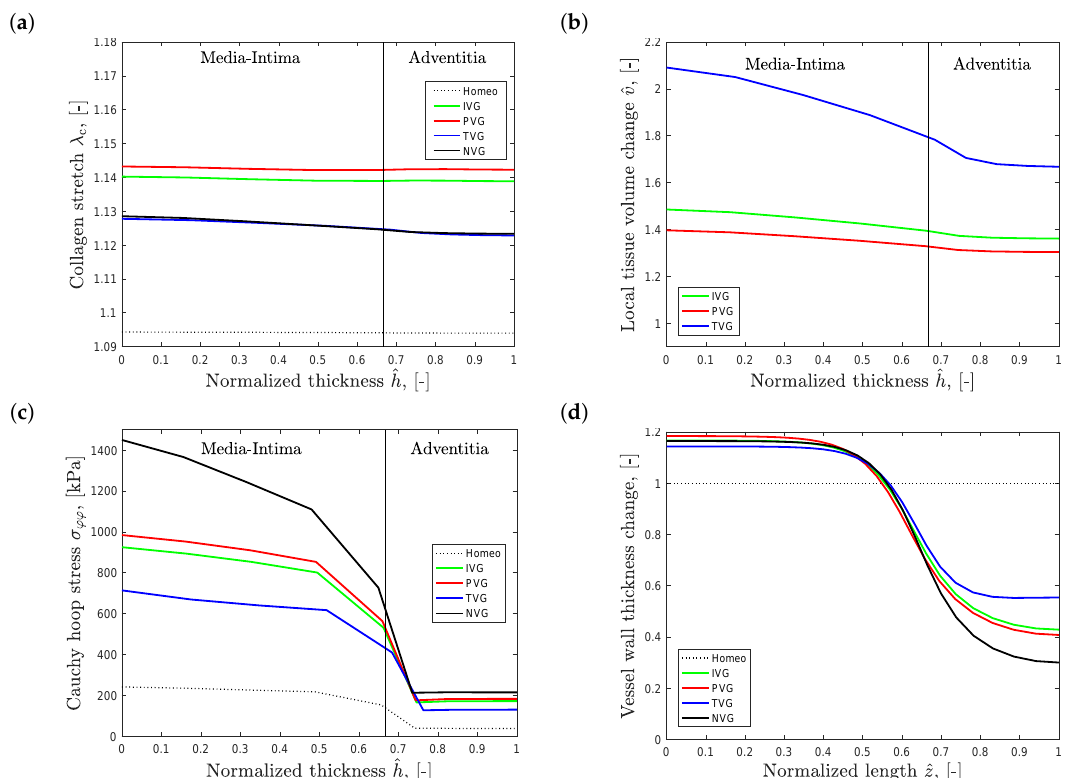
Figure 6. Predicted Abdominal Aortic Aneurysm (AAA) properties at twofold expansion, d i / d 0 = 2. Collagen growth is specified by β = 1.25 (year − 1 ), and Isotropic Volume Growth (IVG), in-Plane Volume Growth (PVG), in-Thickness Volume Growth (TVG) and No Volume Growth (NVG) describe growth kinematics. Transmural plots are shown for ( a ) collagen stretch λ c ; ( b ) local tissue volume change ˆ v ; ( c ) Cauchy hoop stress σ ϕϕ ; ( d ) Vessel wall thickness, normalized to the thickness h 0 of aorta at homeostasis, along AAA